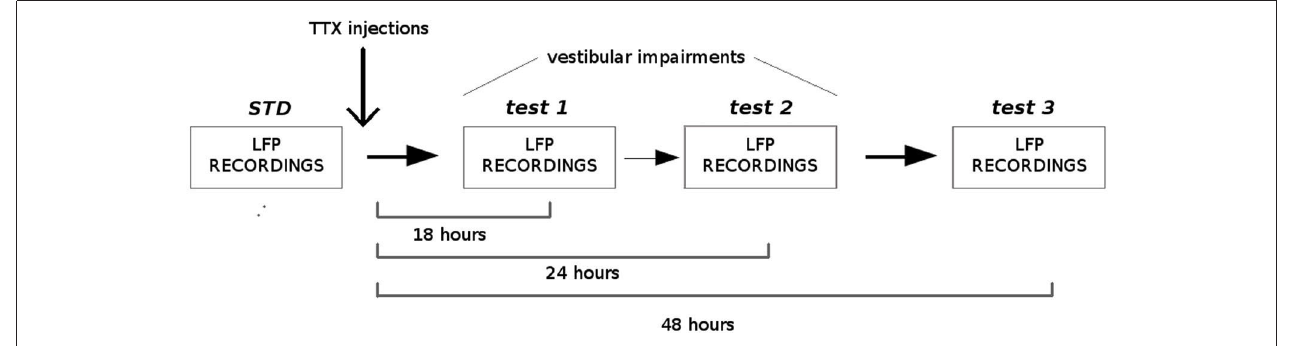
two different tests: the “contact-righting” test and the “landing” test. All rats displayed vestibular impairments at both 18 h and 24 h delays. Vestibular functions were recovered 48 h after TTX injections.